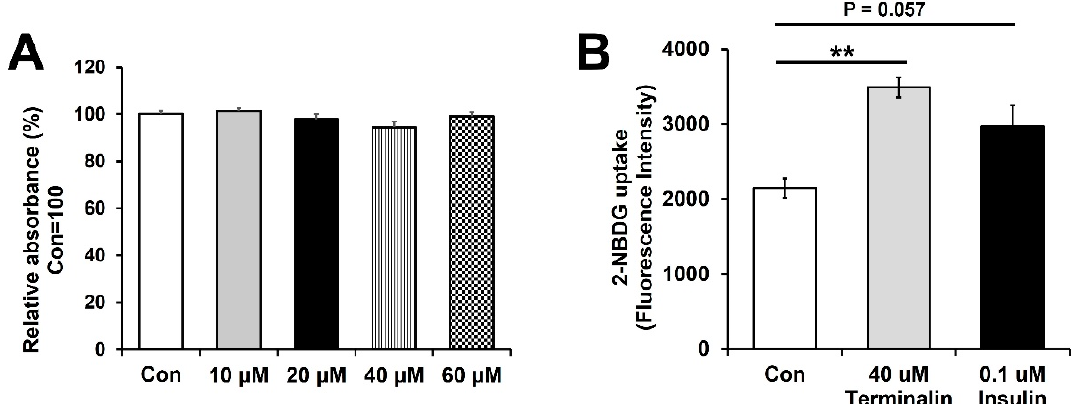
Figure 4. Terminalin increased glucose uptake in differentiated C2C12 muscle cells: ( A ) Differentiated C2C12 muscle cells were treated with the indicated concentrations of terminalin for 48 h, and cell viability was determined using EZ-Cytox assay kit. ( B ) Differentiated C2C12 muscle cells were incubated with 40 μ M terminalin, 0.1 μ M insulin (positive control), or control (0.1% dimethyl sulfoxide) for 6 h (terminalin and control) or 30 min (insulin). Cells were then treated with 2-NBDG, a fluorescent glucose probe, for 30 min, and the fluorescence intensity of the cells was measured. Results are expressed as the mean ± standard error of the mean (SEM). All experiments were conducted independently three times. Data were analyzed using two-tailed unpaired t -test. ** p < 0.01 compared to the control group.